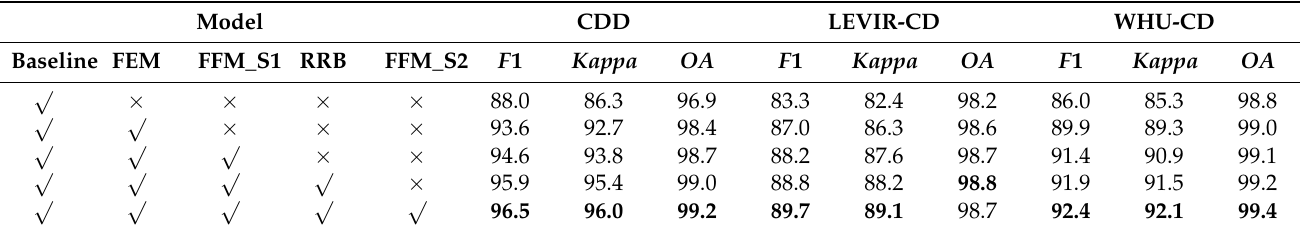
Table 5. Ablation study of different modules on different datasets. All the scores are described in percentage (%). The best scores are highlighted in